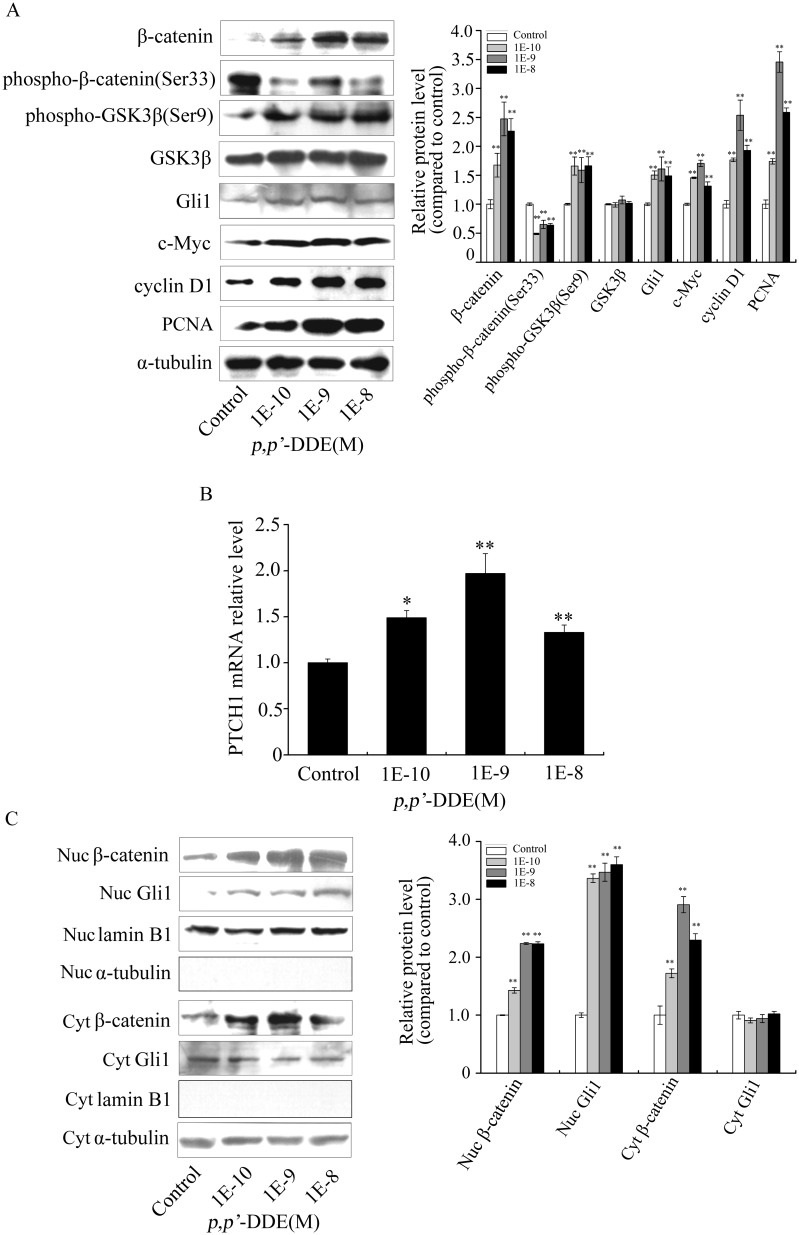

p,p′-DDE upregulates Wnt/β-catenin and Hedgehog/Gli1 signalings in DLD1 cells.After DLD1 cells were treated with p,p′-DDE (10−10, 10−9, 10−8 M) for 96 h, (A) the protein levels of β-catenin, phospho-β-catenin (Ser33), phospho-GSK3β (Ser9), GSK3β, Gli1, c-Myc, cyclin D1 and PCNA were examined by western blotting. α-tubulin was used as the loading control; Grayscale scan analysis of western blot bands from three independent experiments were shown in right panel of graph. **p<0.01 compared to control cells. (B) mRNA expression of PTCH1 was quantified by quantitative real-time PCR analysis. Relative mRNA levels were normalized with control mRNA. The data were acquired from three biologically independent experiments. Value shown was given as the ± SD. *p<0.05 and **p<0.01 compared to control. (C) Western blotting was performed to analyze the amounts of cytoplasmic or nuclear β-catenin and Gli1 proteins. α-tubulin or lamin B1 was used as a control. Grayscale scan analysis of western blot bands from three independent experiments were shown in right panel of graph. **p<0.01 compared to control cells.